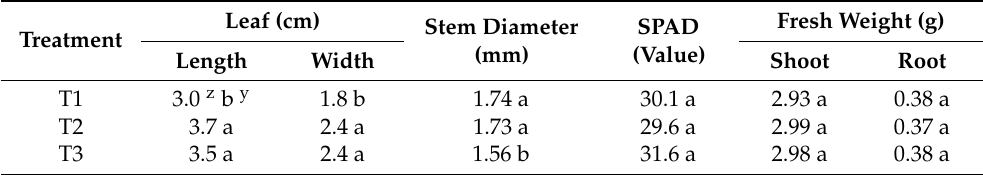
Table 3. Regulations of light intensity treatments on apple